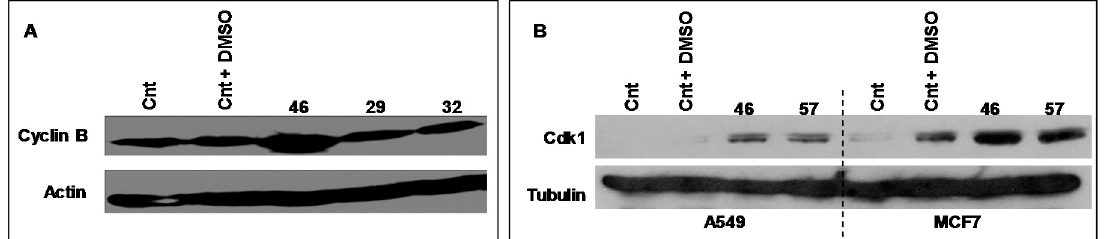
Figure 7. The pictures illustrate the electrophoretic expression profiles of Cyclin B ( A , MCF7 only) and Cdk1 ( B ) of A549 and MCF-7 cells exposed for 24 h to extracts #46, #29 and #32 (0.15%, v / v ). Both panels indicate that this exposure increases the expression of Cyclic B and Cdk-1 proteins. Tubulin ( B ) and actin ( A ) have been used as loading controls, respectively.